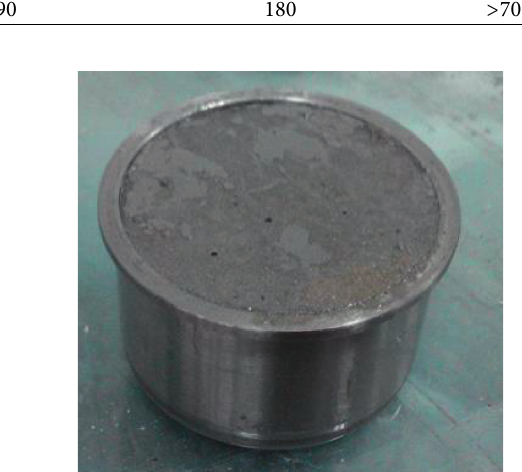
Figure 1: Slurry test sample.